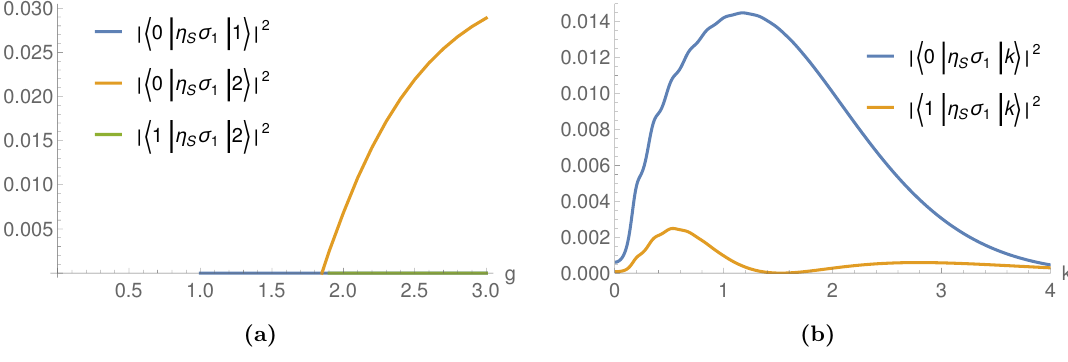
Figure 5. Matrix elements for the operator η S σ 1 between the eigenstates of H 0 for the toy model. The parameters are γ = 3 . 0 and (cid:15) = 0 . 0 . We fix g = 1 . 6 in